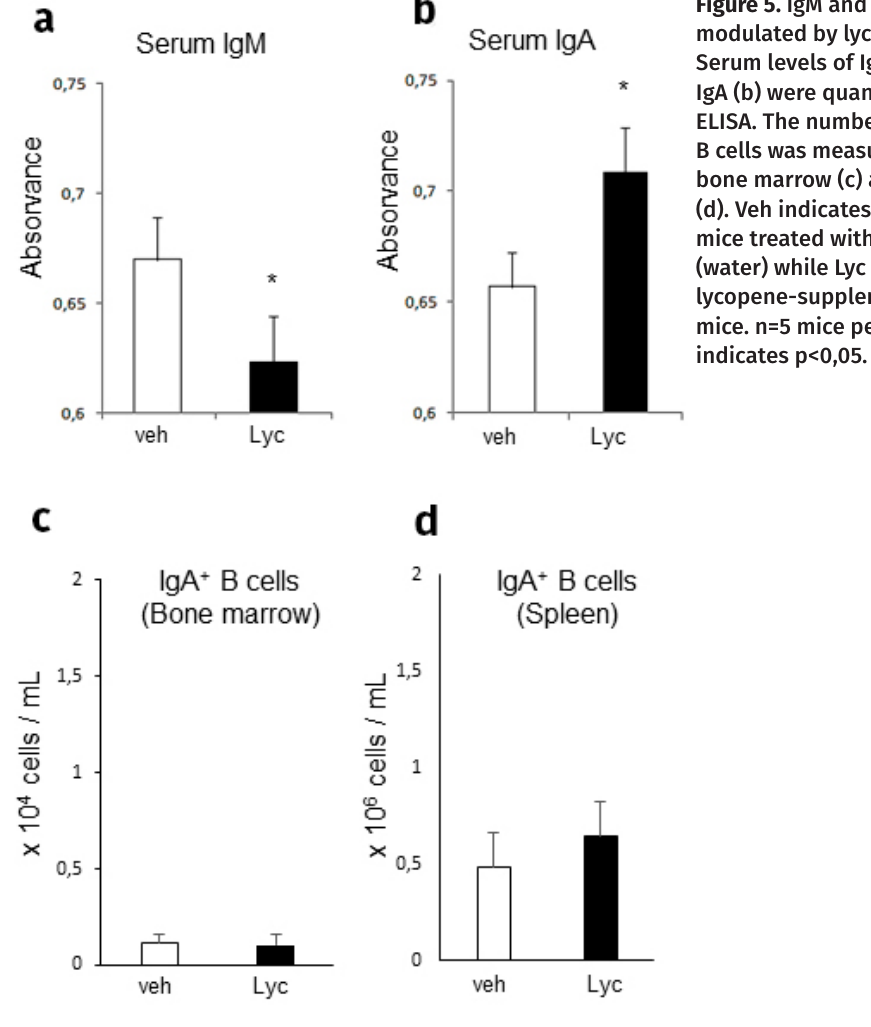
Figure 5. IgM and IgA levels modulated by lycopene. Serum levels of IgM (a) and IgA (b) were quantified by ELISA. The number of IgA+ B cells was measured in the bone marrow (c) and spleen (d). Veh indicates control mice treated with vehicle (water) while Lyc represents lycopene-supplemented mice. n=5 mice per group. * indicates